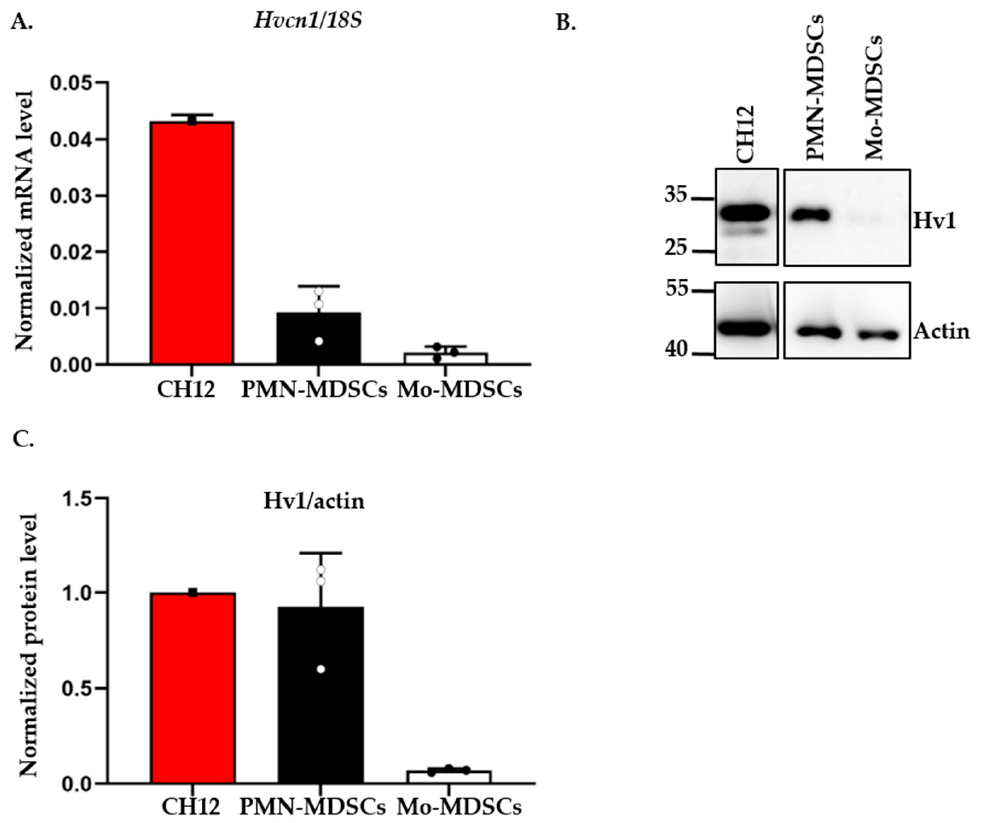
Figure 5. Expression of Hv1 proton channel by murine PMN-MDSCs and Mo-MDSCs at mRNA and protein level. ( A ) Hv1 RNA level relative to 18S RNA expressed by MDSCs using RT-qPCR. The individual data points (empty or filled circles) show the average of duplicates. RNA extracted from the CH12 B cell lymphoma cell line was used as a positive control. Bars and error bars indicate mean ± SD (PMN-MDSCs, n = 3; Mo-MDSCs, n = 3). ( B ) Western blot analysis of Hv1 proton channel protein from the sorted MDSCs: protein lysate from CH12 B cell lymphoma was used as a positive control and actin as a housekeeping protein. ( C ) Densiometric analysis of Hv1 protein level expressed by PMN- and Mo-MDSCs relative to actin expression. Densitometric data were obtained for 3 independent sets of sorted cells. Bars and error bars indicate mean ± SD (PMN-MDSCs, n = 3; Mo-MDSCs, n = 3).